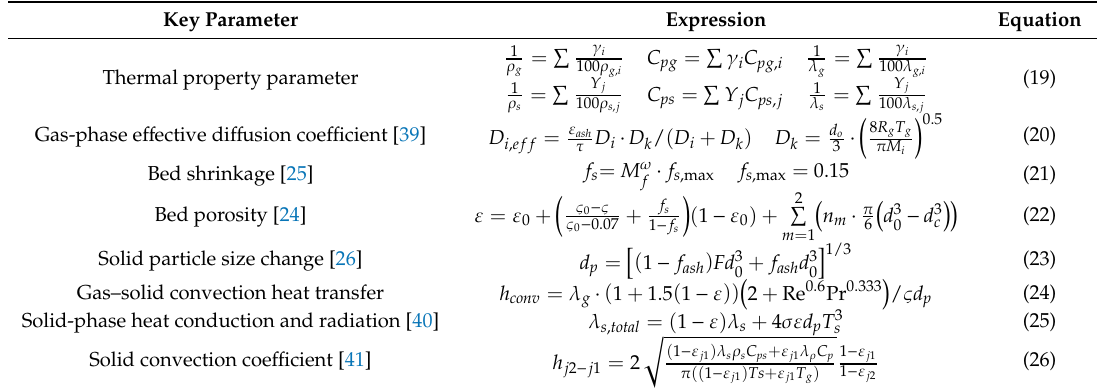
Table 1. Key parameters in the